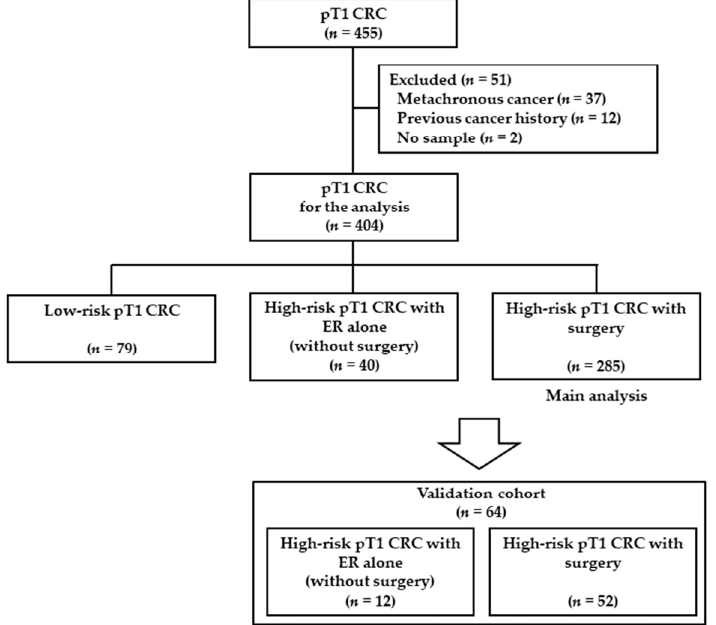
Figure 1. Study flowchart. pT1, pathology stage T1; CRC, colorectal cancer; ER, endoscopic resec- tion.